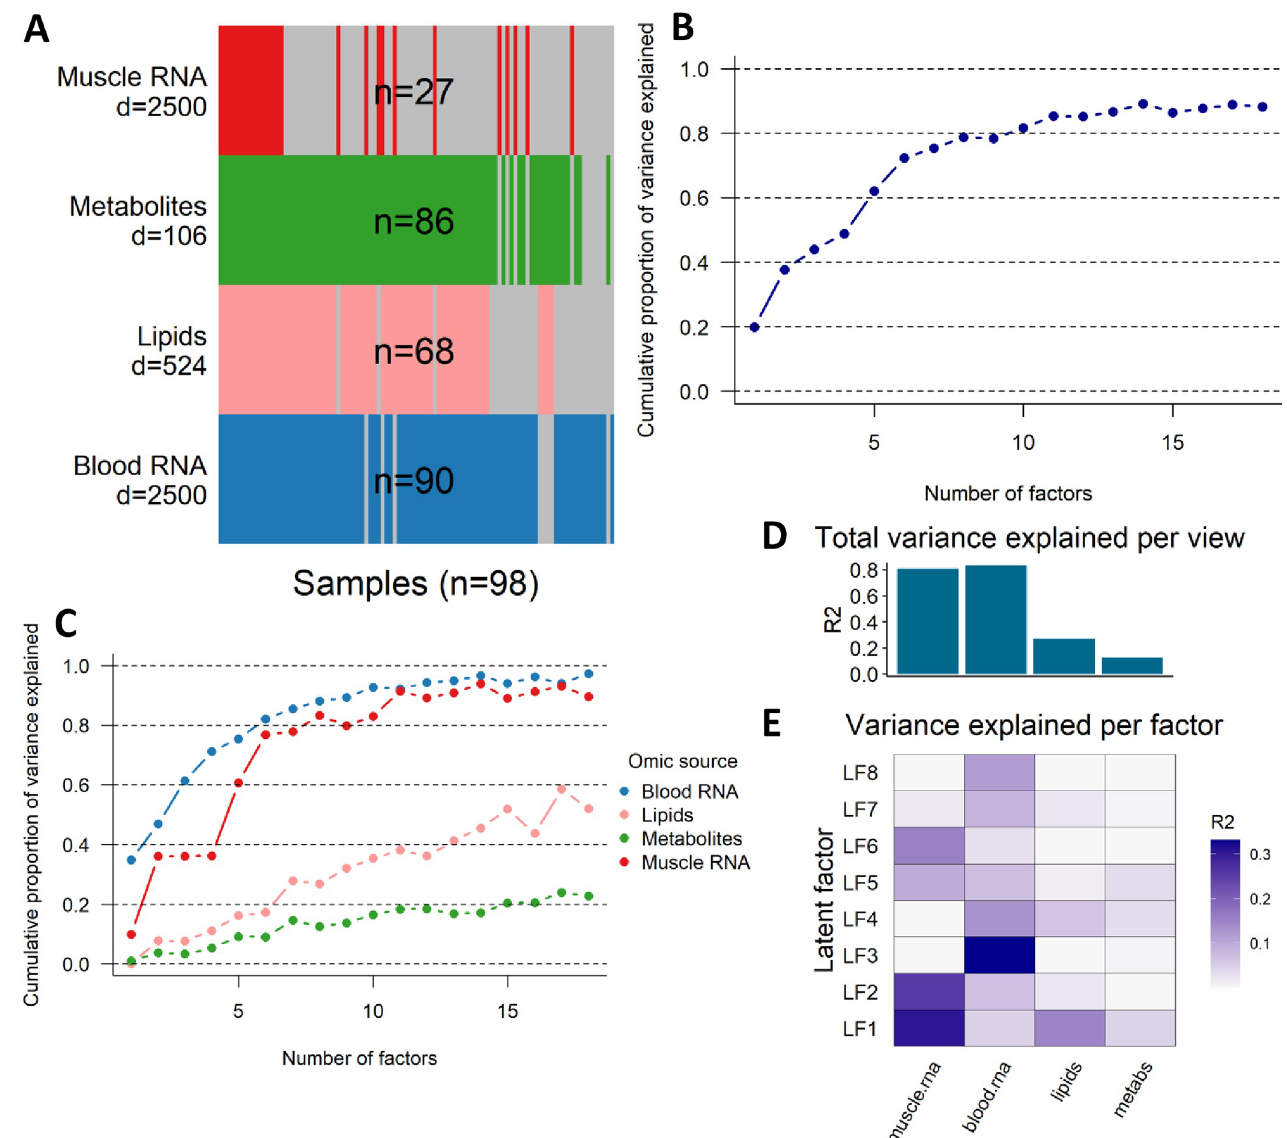
Fig 2. Summary of the multi-omics factor analysis. A) Data overview showing the number of samples (n) and molecules (d) available in each omic view. A grey bar indicates that the sample is missing in the given omic view. B) Cumulative proportion of variance explained for MOFA fits with increasing number of factors. C) Cumulative proportion of variance explained by omic view for MOFA fits with increasing number of factors. D) Total percentage of variance explained (R2) by omic view (top), and percentage of variance explained by each latent factor in the different omic views (bottom) for the selected MOFA model. E) Comparison of the distribution of the factor loadings across different omic